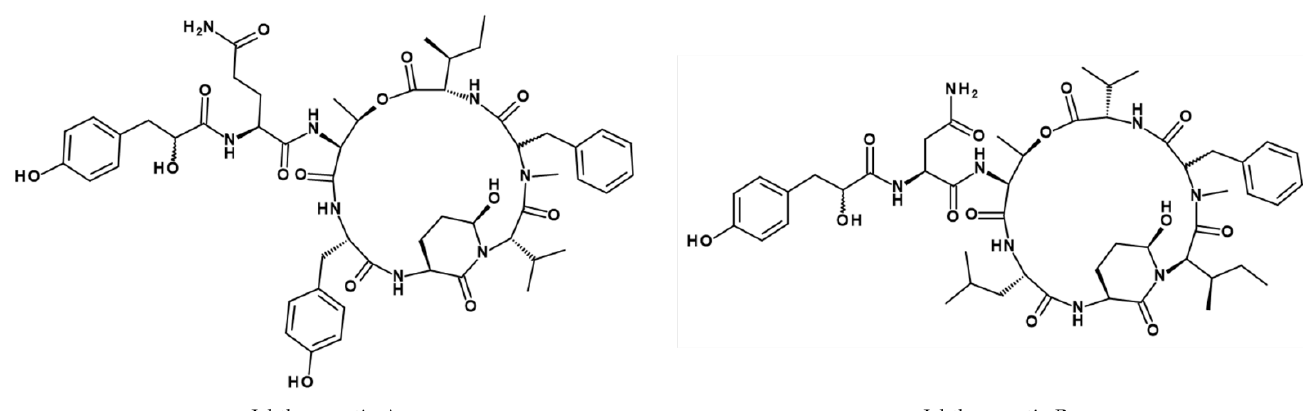
Figure 8. Structures of ichthyopeptin A and B [141] .